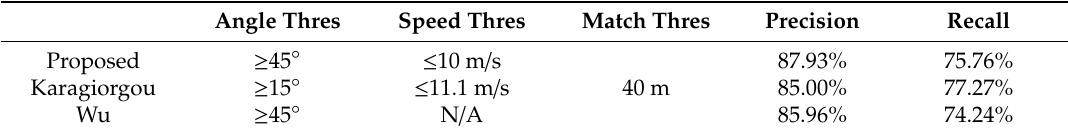
Table 7. Comparison of using di ff erent criteria in turn-point selection.